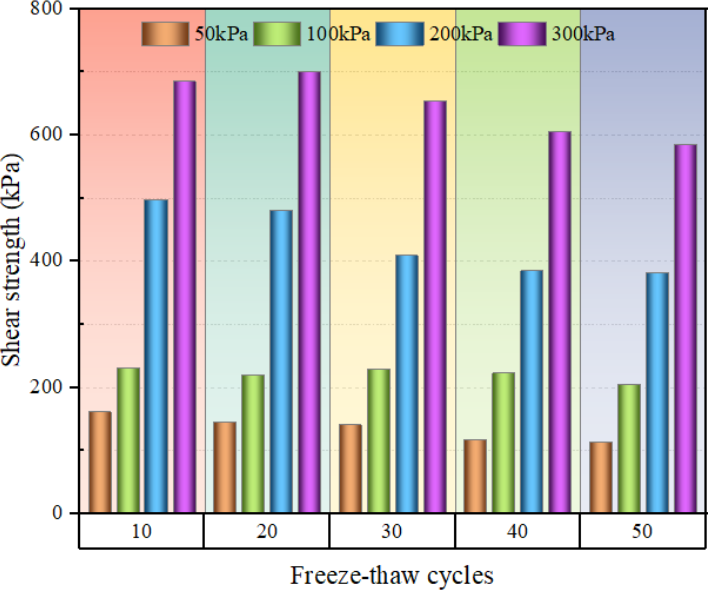
Figure 4. Shear strength of tailings under different confining